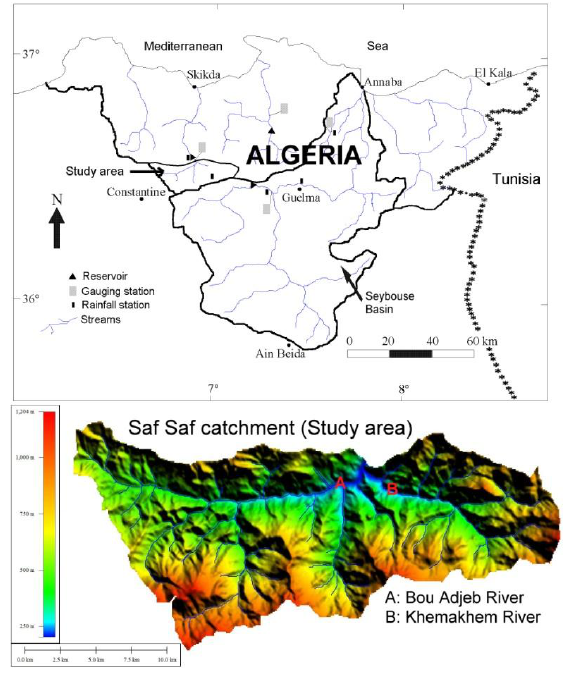
Figure 1: Location map of the Saf Saf catchment.